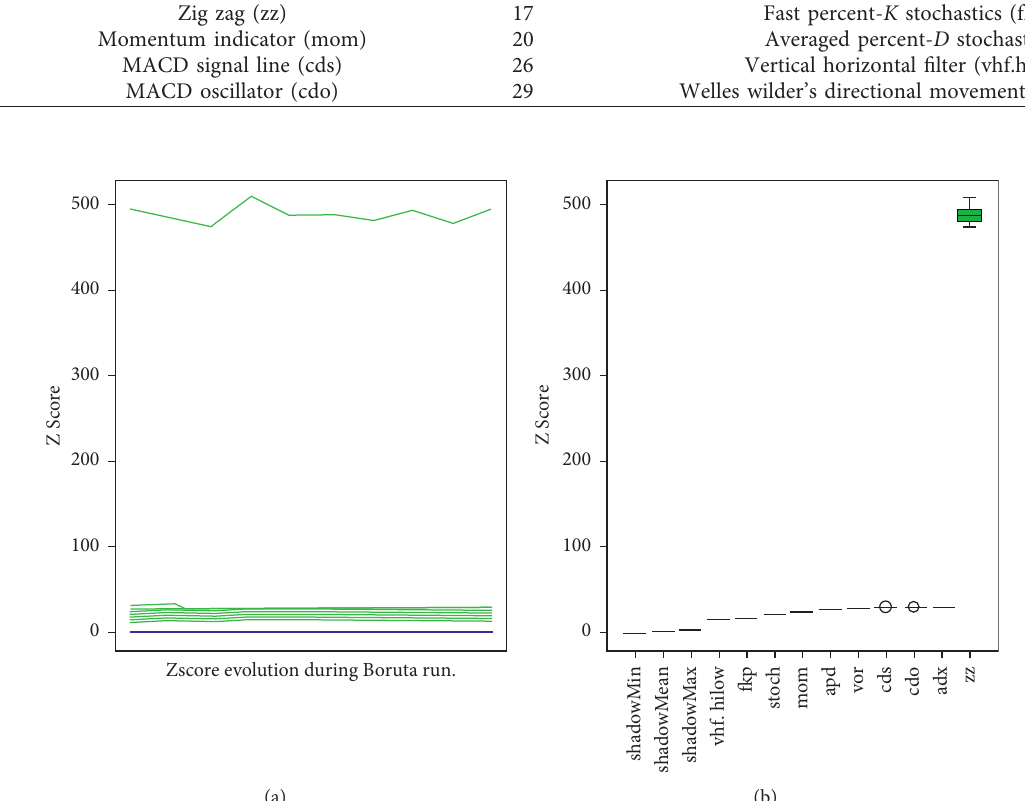
Figure 7: Boruta result plot (a) and plot of important history (b) on the Boruta on technical indicators